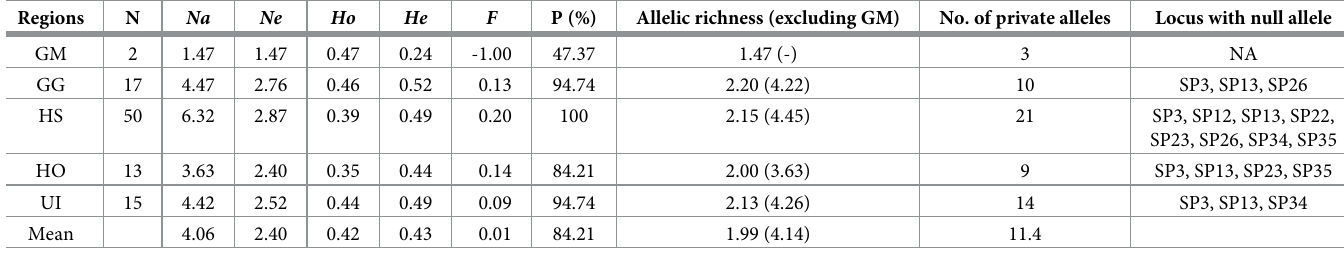
Table 2. Genetic diversity statistics over 19 loci for five populations of Saussurea polylepis .